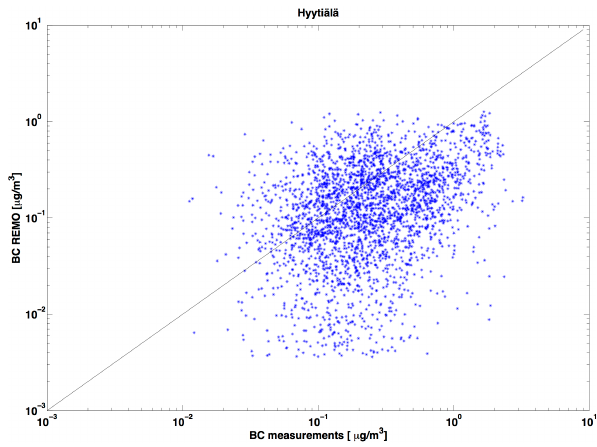
Fig. 6. 3-hourly scatter plot of the black carbon concentrations in Hyyti¨al¨a (2005): model vs